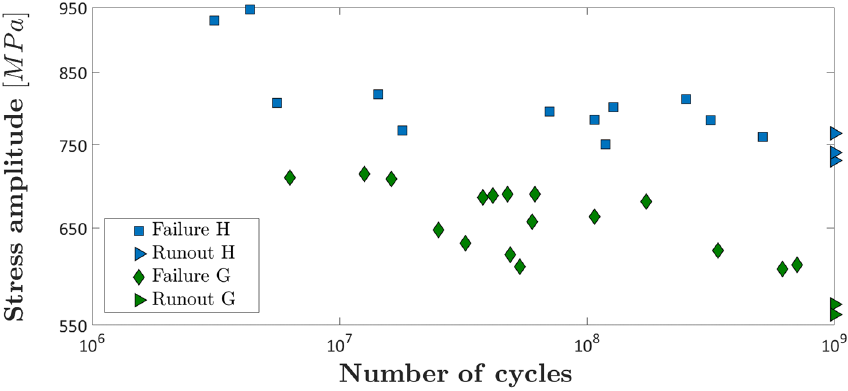
Figure 4. S–N plot of the experimental dataset.